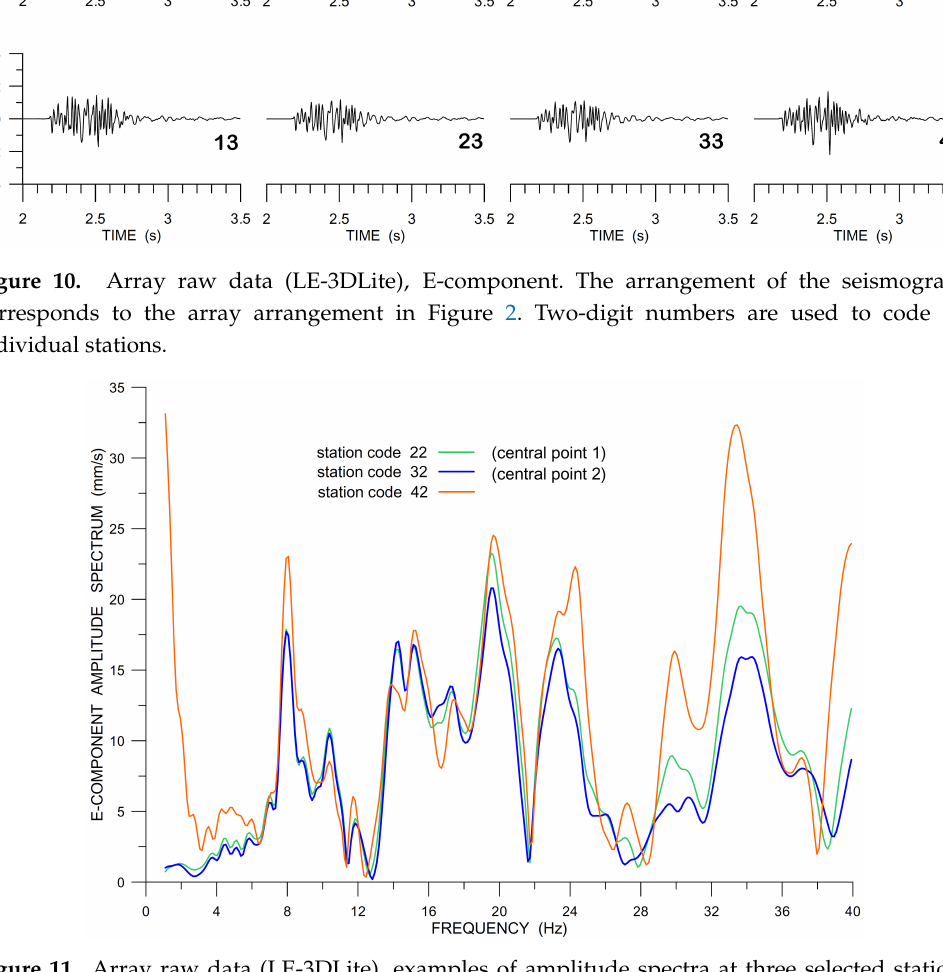
Figure 11. Array raw data (LE-3DLite), examples of amplitude spectra at three selected stations,